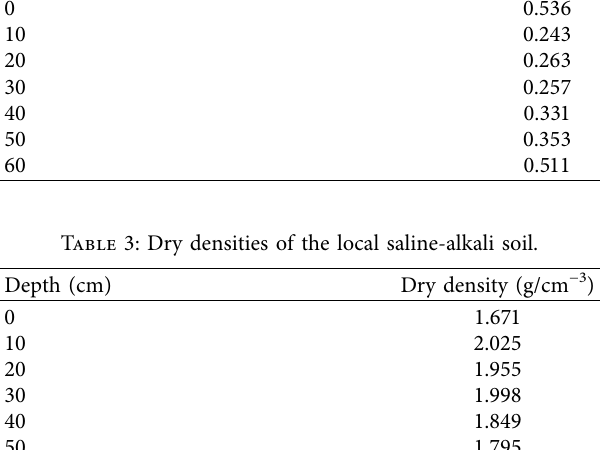
Table 2: Void ratios of the local saline-alkali soil. Depth (cm) Void ratio